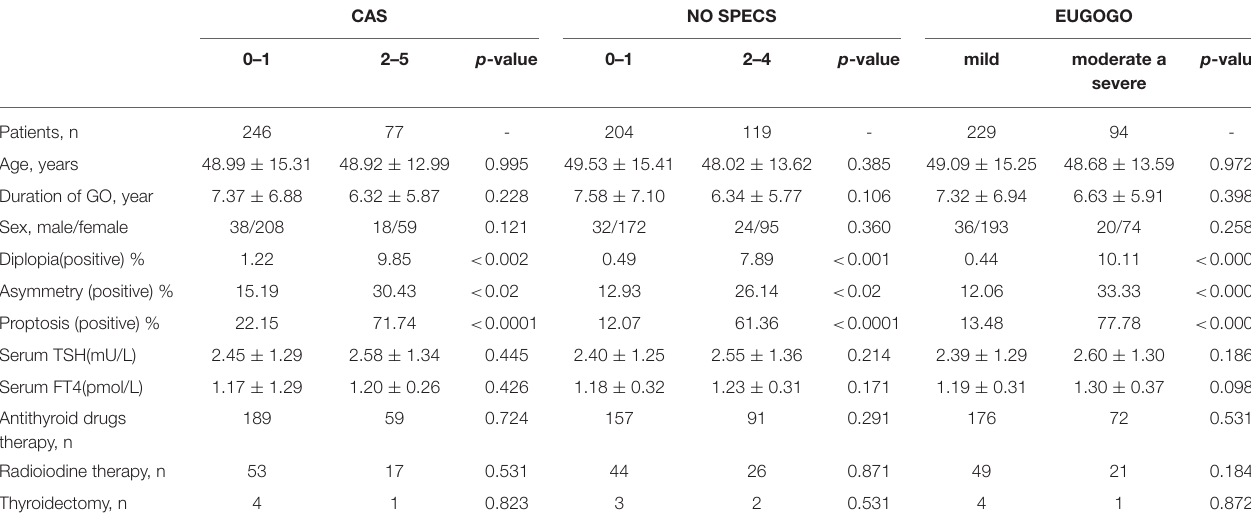
TABLE 2 | Characteristics of the selected GO patients from the inicial study: comparison of clinical variables among the GO classifications.